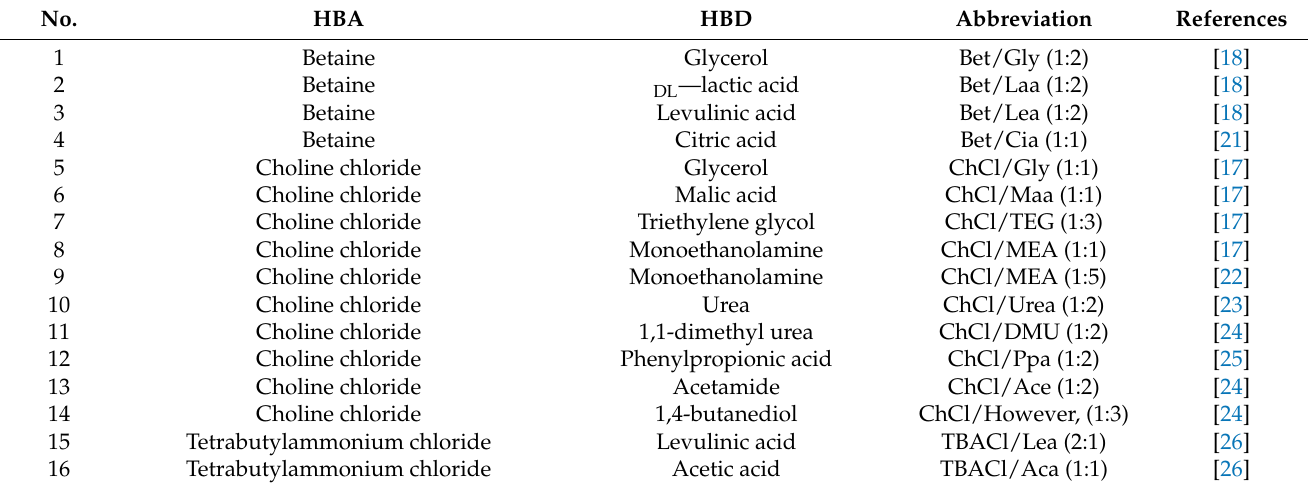
Table 3. List of deep eutectic solvents (DESs) used in COSMO-RS